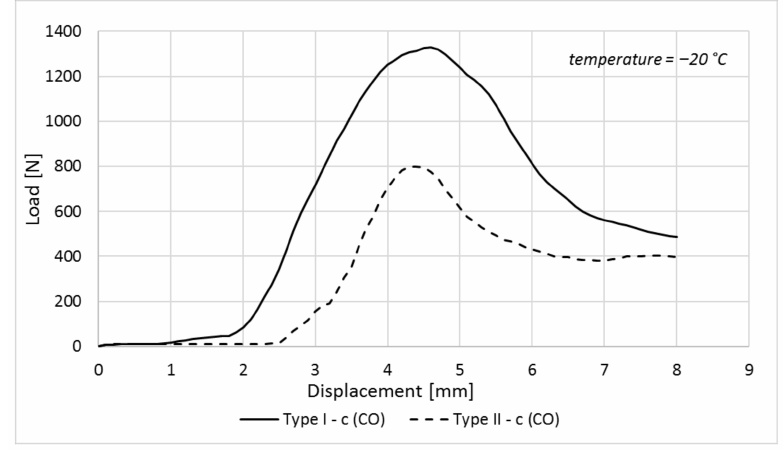
Figure 17. Closing force curves obtained for − 20 ◦ C.